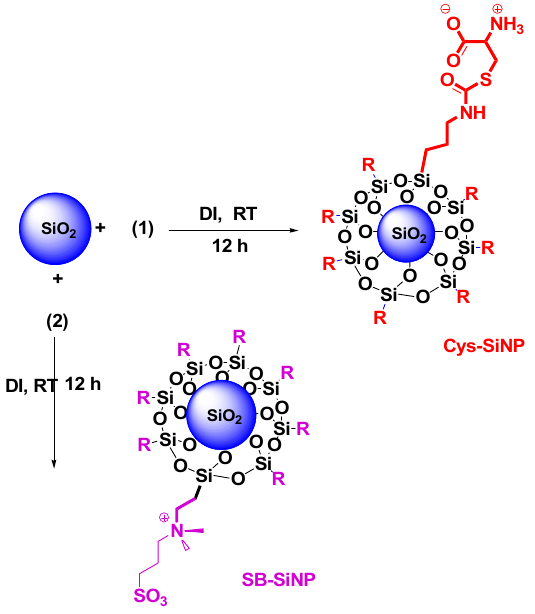
Fig. 1. The synthesis pathway for surface modification of Bare-SiNPs with ligand 1 and 2 to fabricate Cys-SiNPs and SB-SiNPs was represented.